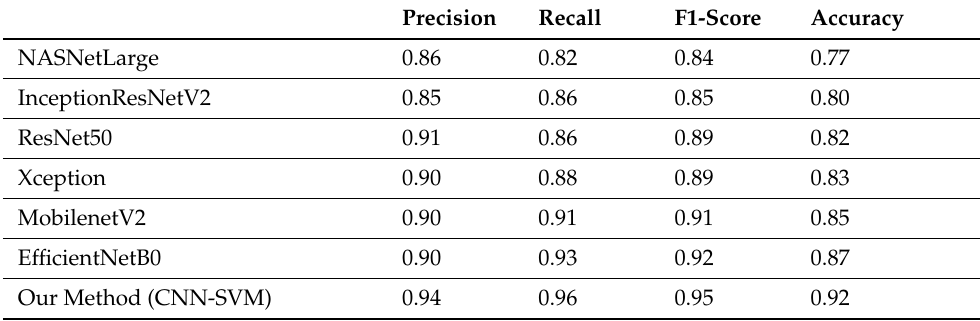
Table 2. Classification report for the used seven models in our study. Precision Recall F1-Score